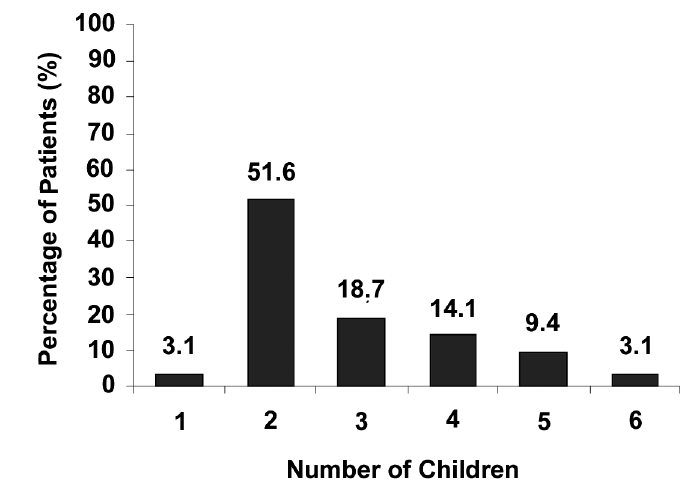
Figure 1 – Number of children per vasectomized